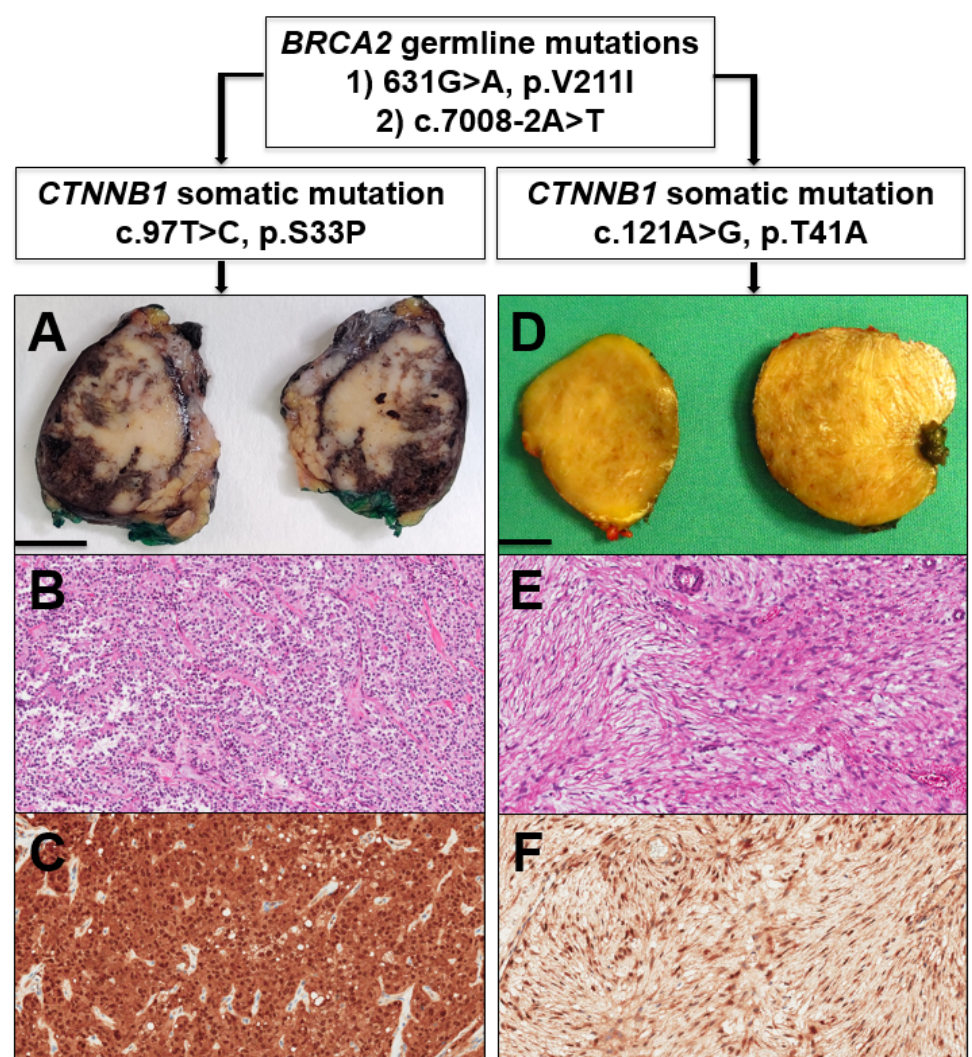
Figure 1. Graphical summary of the presented case. In the genetic background of two different BRCA2 germline mutations, the patient first developed a solid pseudopapillary neoplasm of the pancreas. ( A ) Gross appearance, scale bar = 1 cm; ( B ) Histology, hematoxylin-eosin staining, original magnification 10 × ; ( C ) Nuclear positivity for β -catenin at immunohistochemistry, original magnification 10 × and, two years after its surgical resection, a desmoid tumor; ( D ) Gross appearance, scale bar = 1 cm; ( E ) histology, hematoxylin-eosin staining, original magnification 10 × ; ( F ) Nuclear positivity